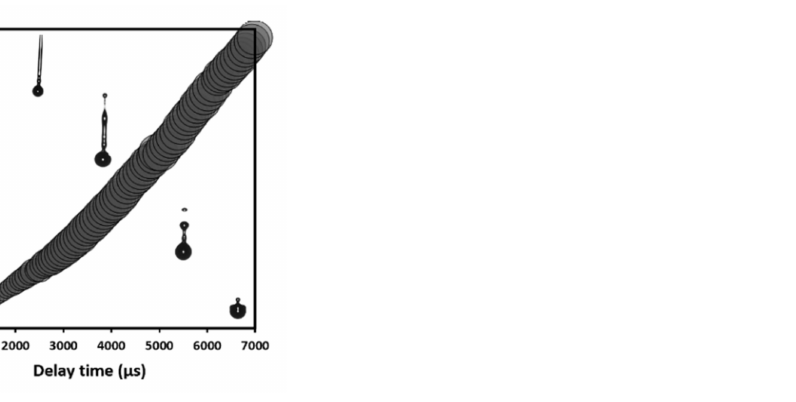
Figure 3. Dependence of the centre of mass (CoM) of jetted drops vs. flight delay time superimposed with the relevant visualisation drop images for the YDC